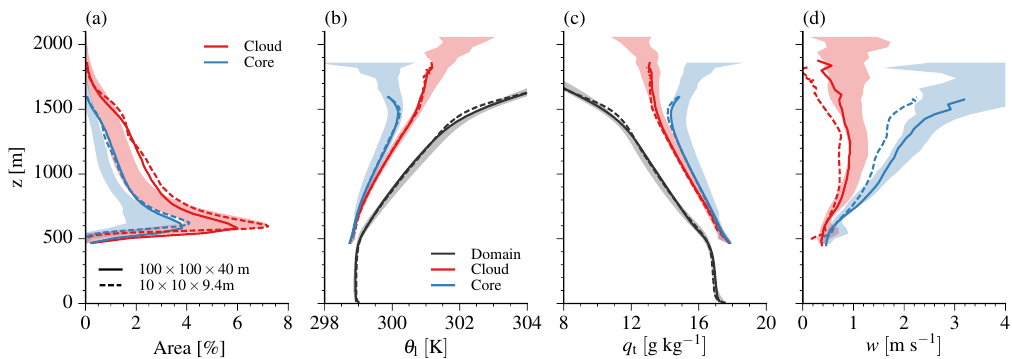
Figure 10. BOMEX LES intercomparison (S03). Shown are the domain mean, and conditionally sampled cloud ( q l > 0) and cloud core ( q l > 0 and b −(cid:104) b (cid:105) > 0) vertical profiles of (a) area coverage of cloud and cloud core, (b) liquid water potential temperature, (c) total specific humidity, and (d) vertical velocity. The results are averaged over t = 18000–21600s. The shaded area denotes the mean ± 1 standard deviation of the participating models from S03; the solid and dashed lines the results from MicroHH, using the original (solid) and a higher- resolution (dashed) setup.